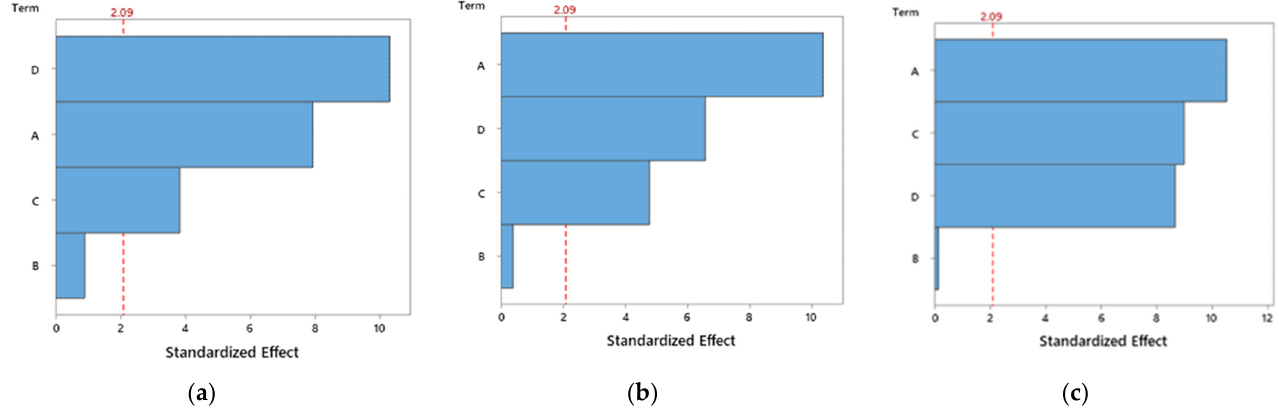
Figure 7. Pareto diagram for PETG+CF and for: ( a ) bending stress; ( b ) bending modulus; ( c ) bending strain.